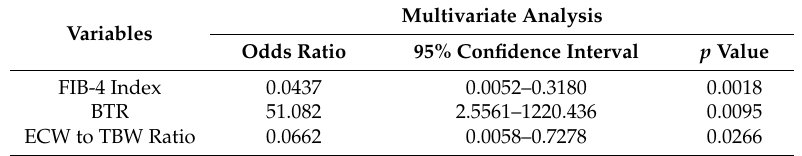
Table 7. Significant factors in the multivariate analyses for the presence of CONUT ≥ 5.